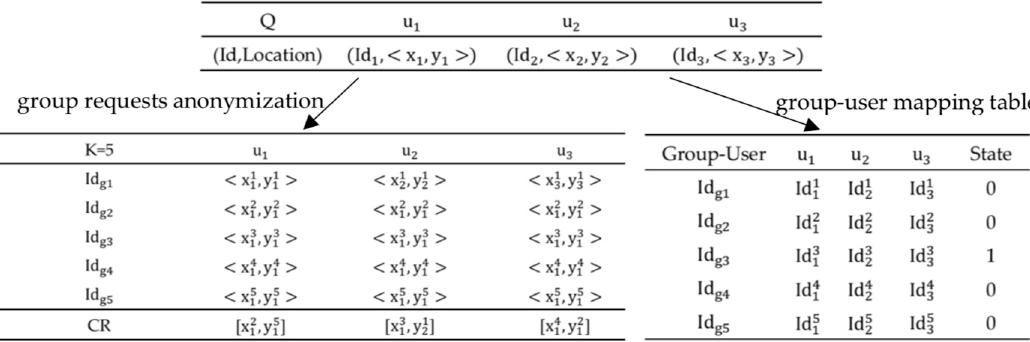
Figure 5. Anonymous process.